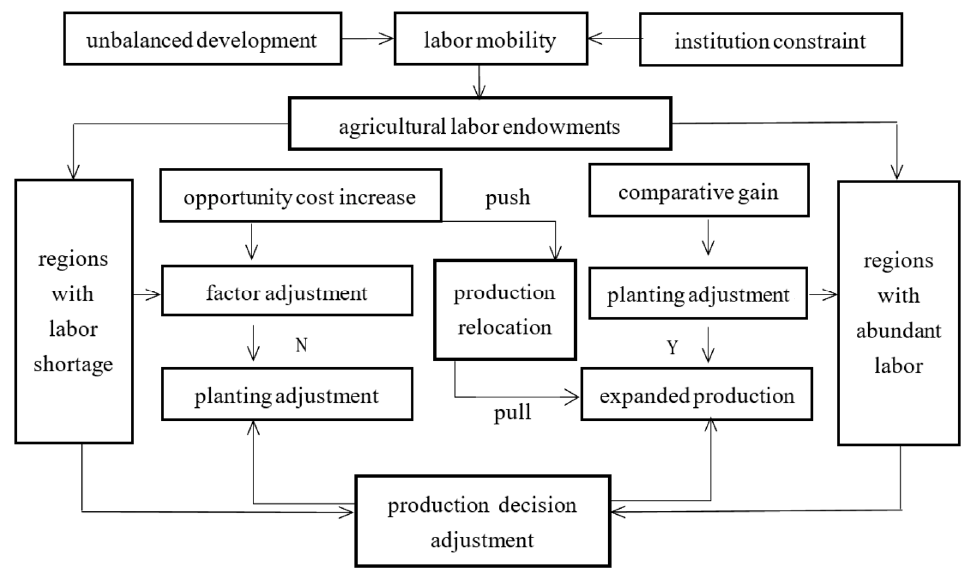
Figure 1. Mechanism of regional difference in labor endowment on agricultural production location adjustment.